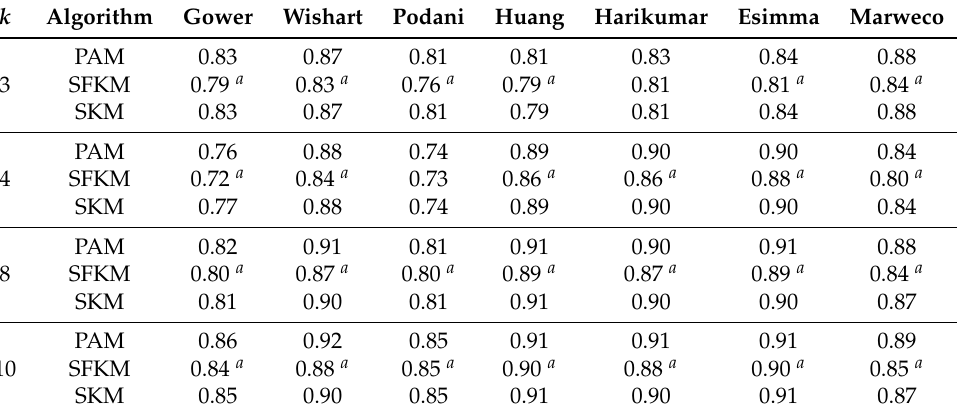
Table 5. Rand indices of the different numbers of clusters.